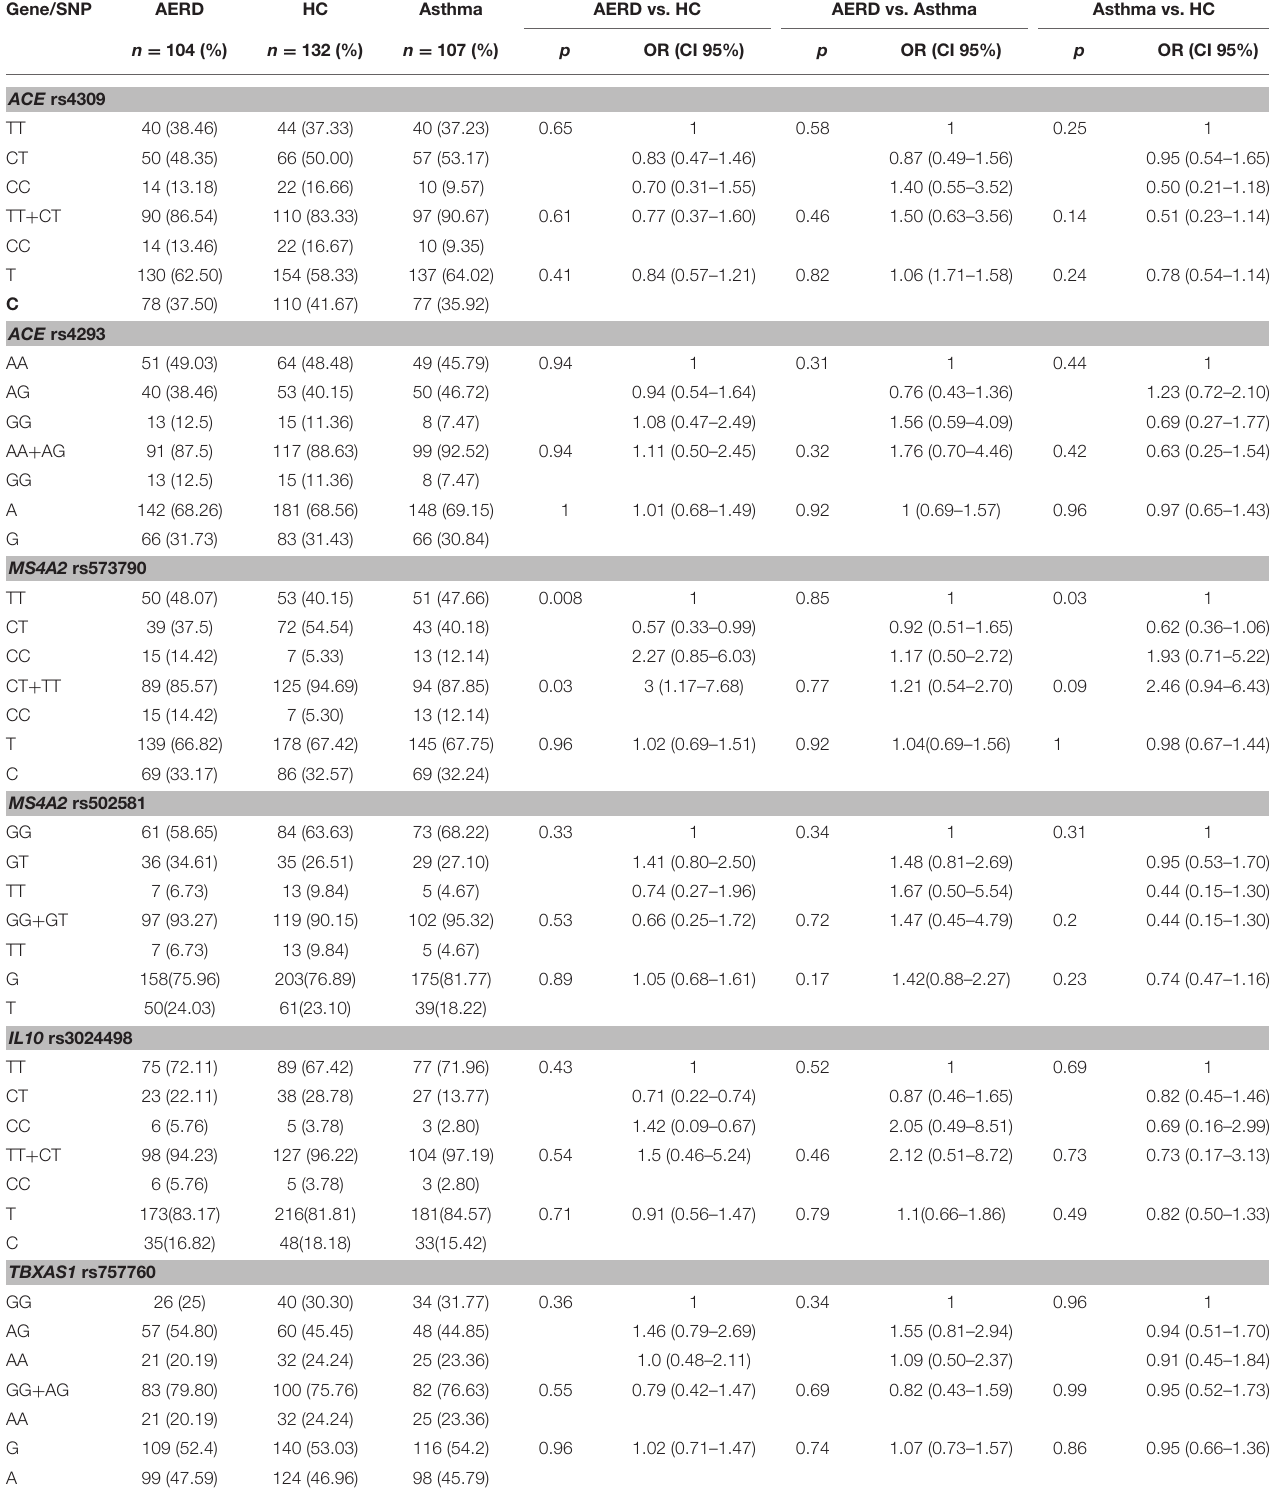
TABLE 6 | Co-dominant and recessive genetics models of Stage